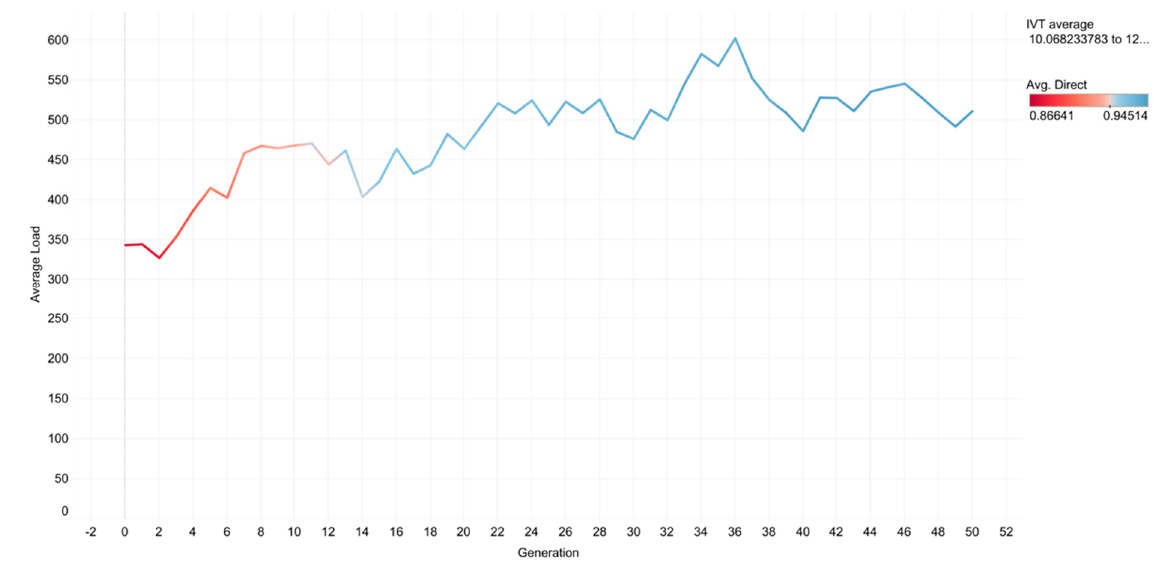
Figure 7. Histogram of number of chromosomes per fleet size (color notes user cost, with blue and red marking low and high user costs respectively).